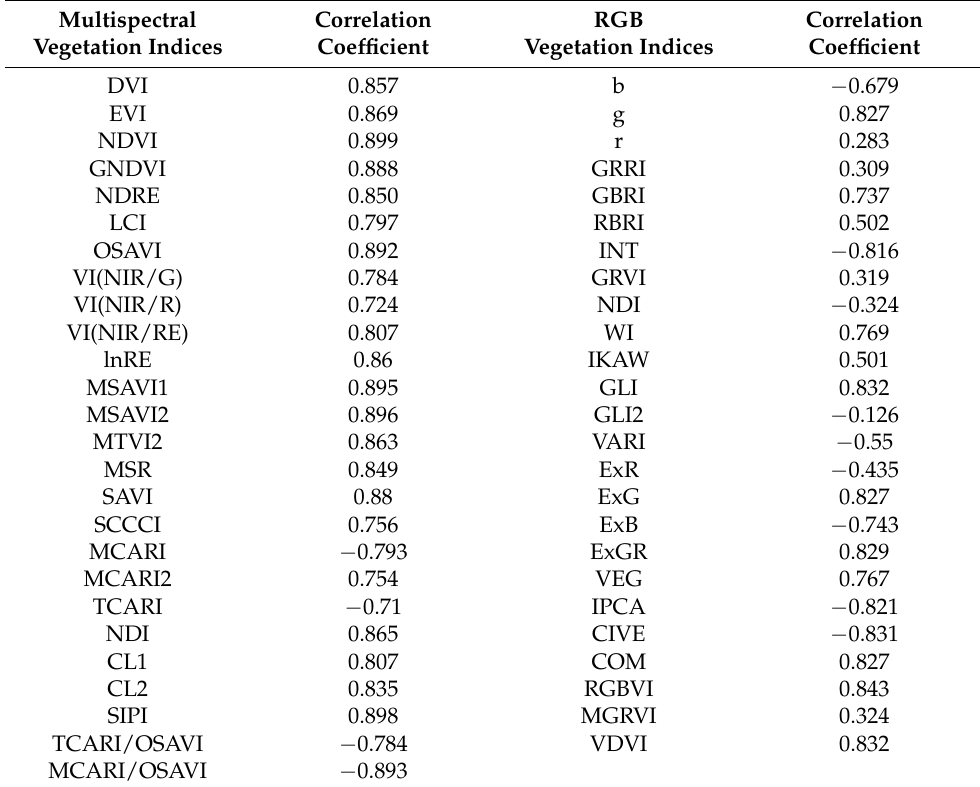
Table 7. Correlation coefficients between MS, RGB vegetation indices, and Fv/Fm. Multispectral Correlation RGB Correlation Vegetation Indices Coefficient Vegetation Indices